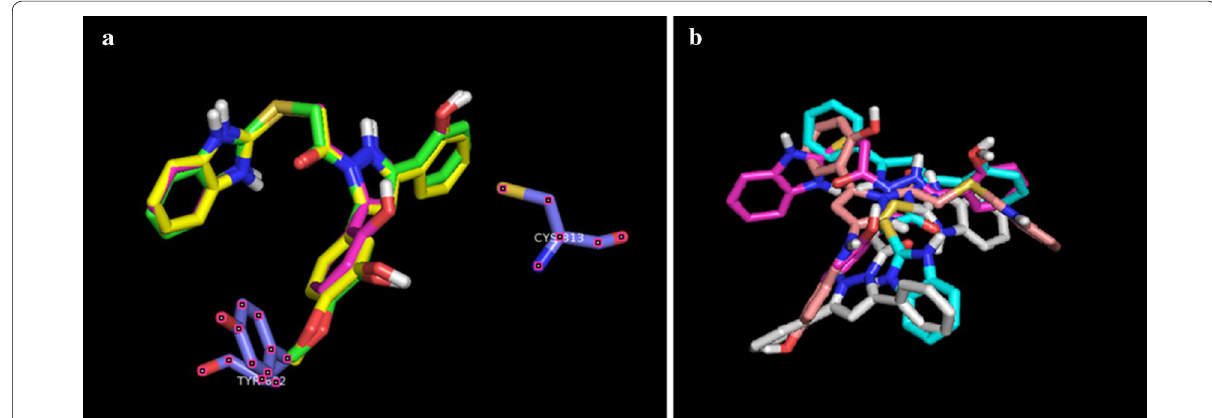
Fig. 3 5b, 5c and 5f between Cys 813 and Tyr 802 of binding pocket ( a ) their binding poses are same and are overlapping with each other. 5a, 5b, 5d and 5e have different binding poses ( b )